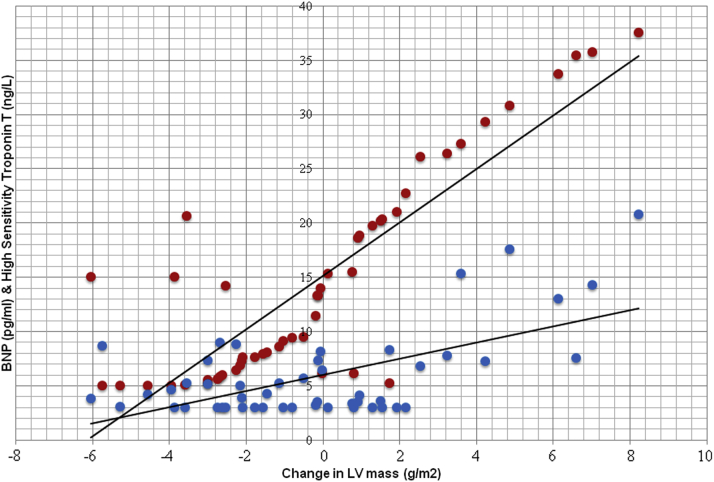
Distribution of Baseline BNP and hs-TnT Levels Across the Range of ΔLVMRed dots represent B-type natriuretic peptide (BNP) and blue dots represent high-sensitivity troponin T (hs-TnT). ΔLVM = change from baseline in left ventricular (LV) mass.